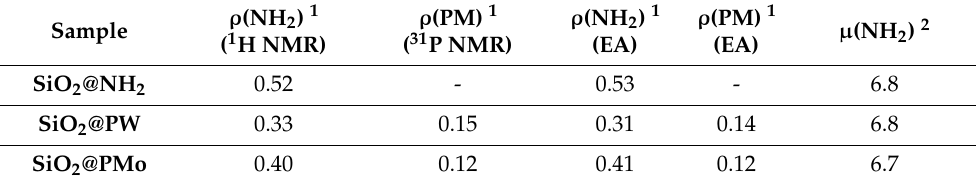
Table 2. Calculated ρ (NH 2 ) and ρ (PM) data and surface coverage µ (NH 2 ).